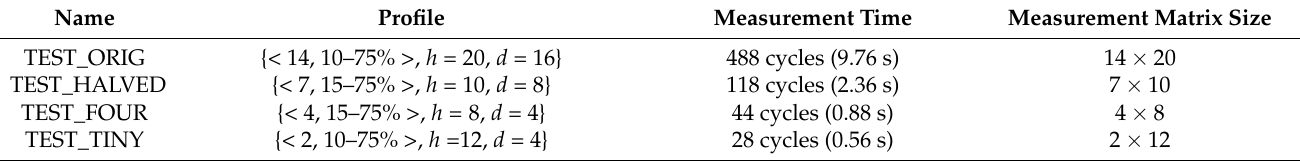
Table 1. Measurement Profiles and their properties. The measurement profiles are displayed in the following format: { < r , percentage _ min − percentage _ max > , h , d }